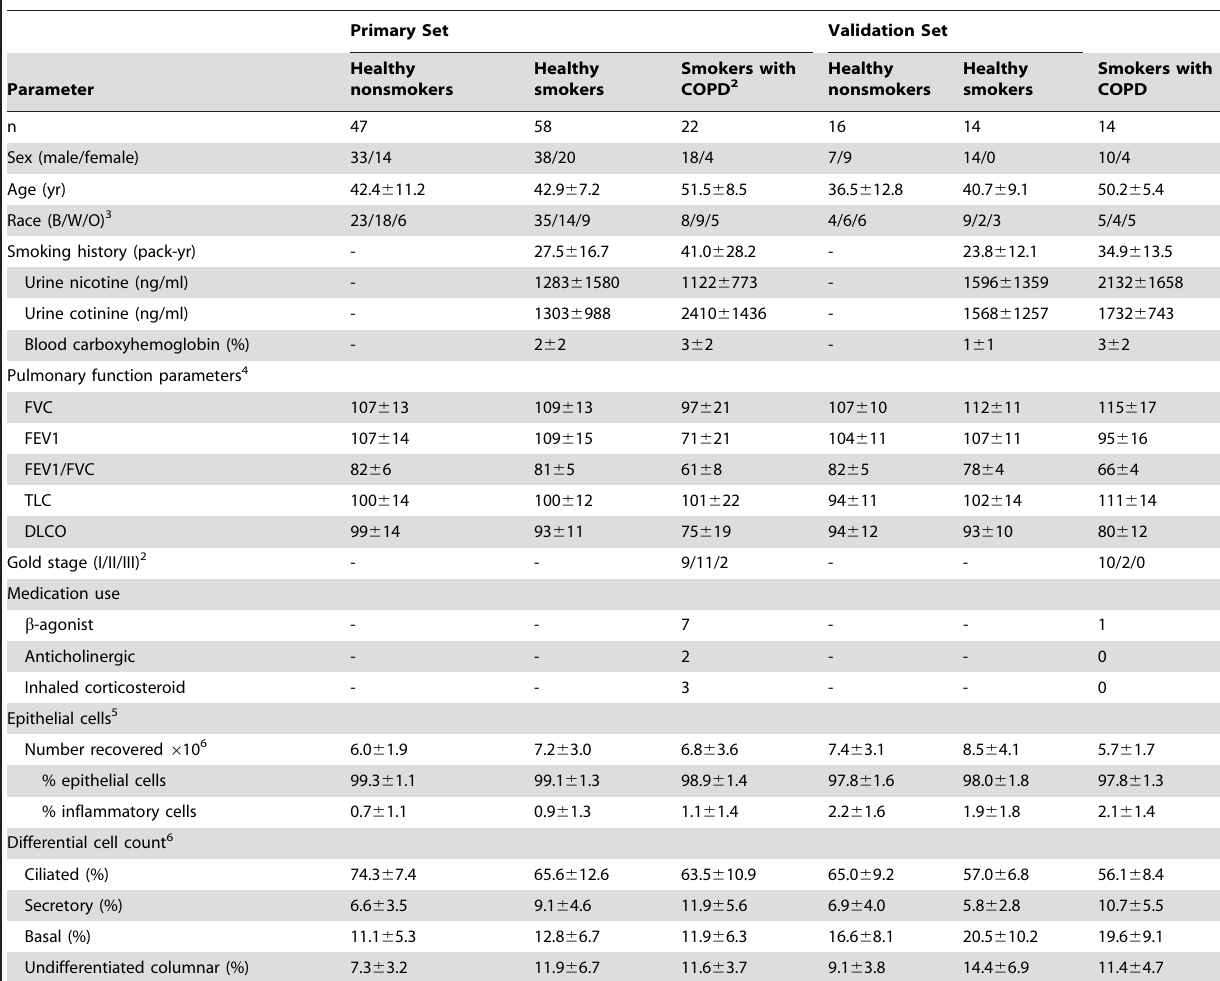
Table 1. Demographics of the Study Population and Biologic Samples 1